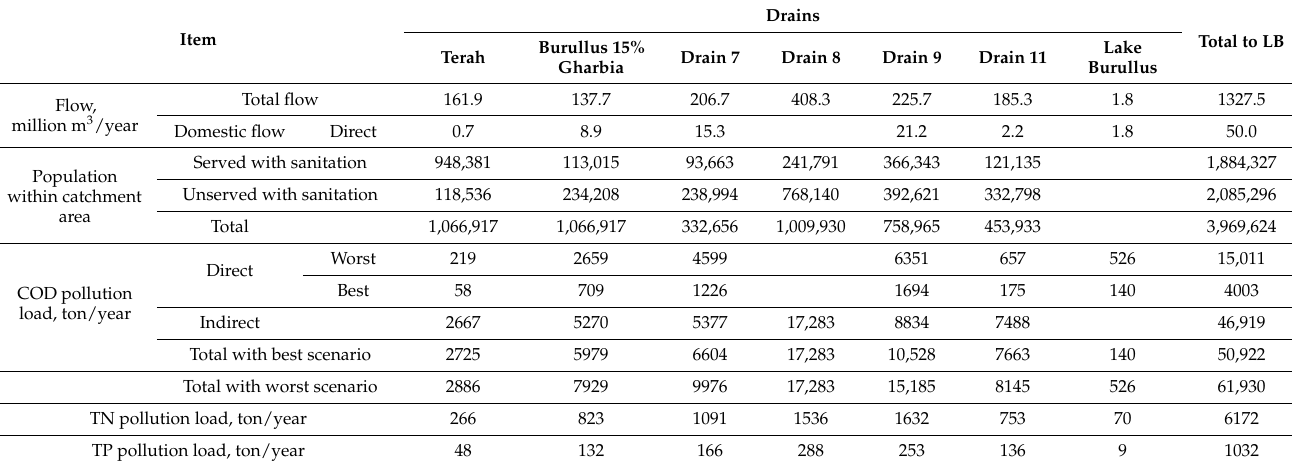
Table 6. Flow and pollution loads into Lake Burullus due to domestic wastewater pollution